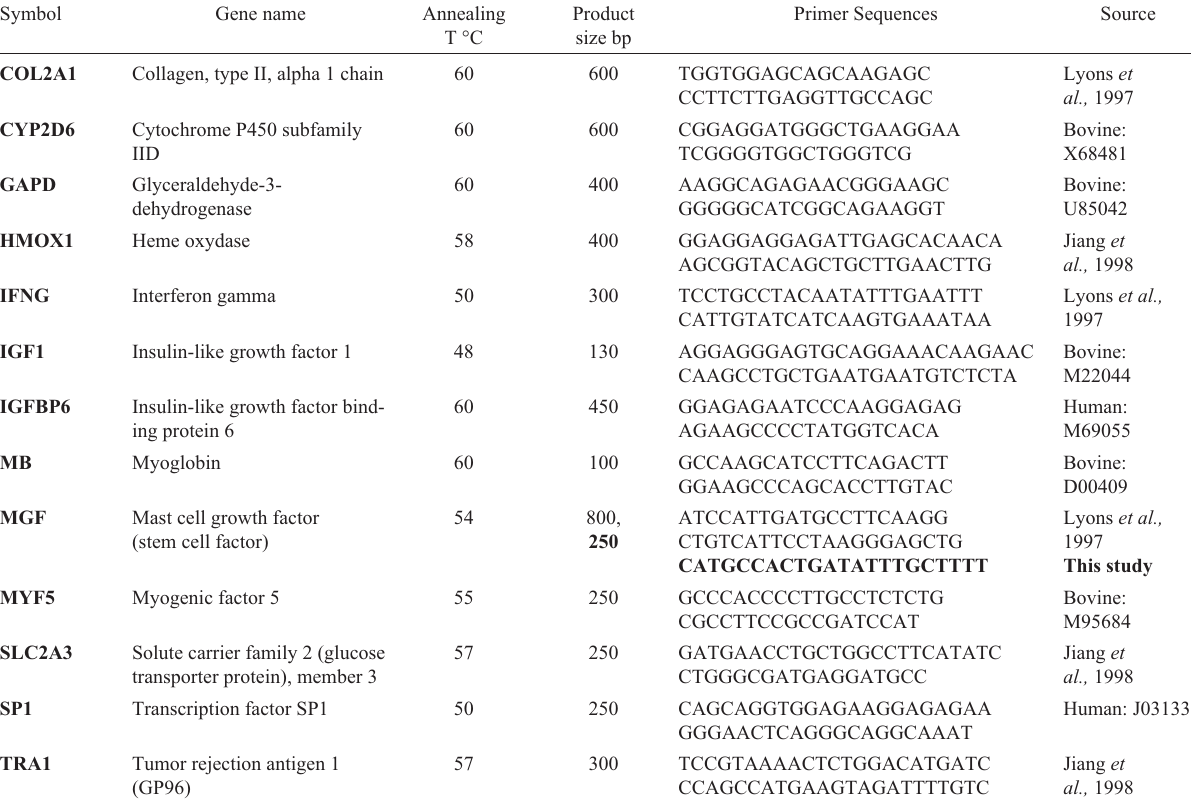
Table 1 - Genes and primer information for the type I loci scored in the RH map of BTA5. Gene symbols are in accordance with the Human Gene Nomenclature database. Product sizes are approximate. The species and GenBank accession numbers of the sequences used for designing the primers used in this study are shown in the source